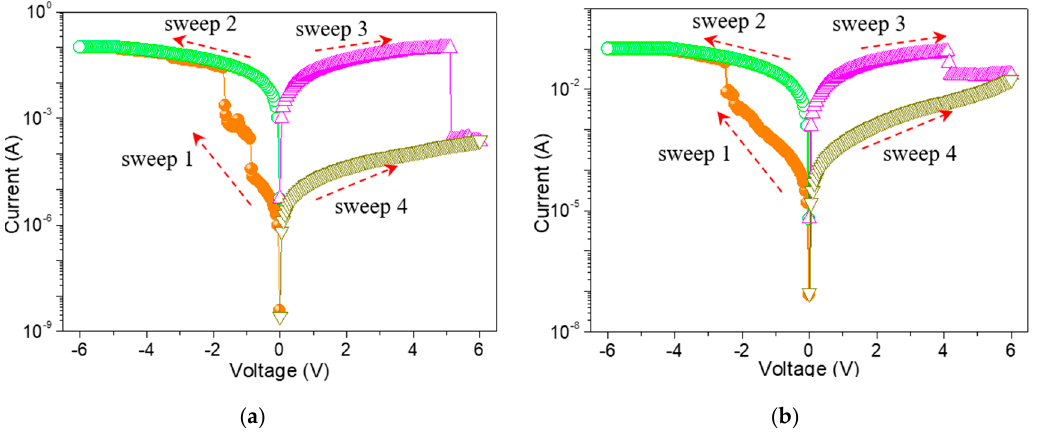
Figure 6. Memristic switching characteristics for ( a ) ITO/GO:0.5 wt%GQDs/Ni and ( b ) ITO/GO/Ni.